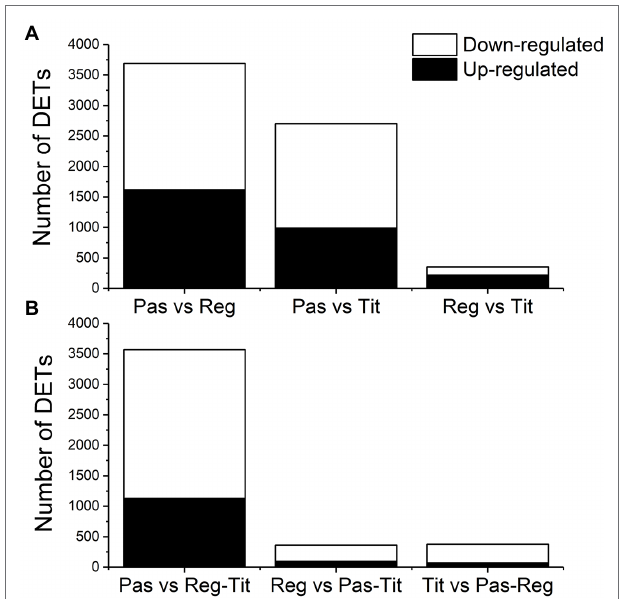
FIGURE 6 | (A) Number of differentially expressed transcripts (DETs) as identified by DESeq2 from pairwise comparisons between the three quinoa genotypes Pasankalla, Regalona, and Titicaca after setting thresholds of adjusted value of p ≤ 0.01 and log2FC > 1.0. (B) Number of differentially expressed transcripts as identified by DESeq2 from comparisons between one genotype against the two other [Pasankalla (Pas), Regalona (Reg), and Titicaca (Tit)] after setting thresholds of adjusted value of p ≤ 0.01 and log2FC > 1.0. FC, fold change. Also see data provided in Supplementary